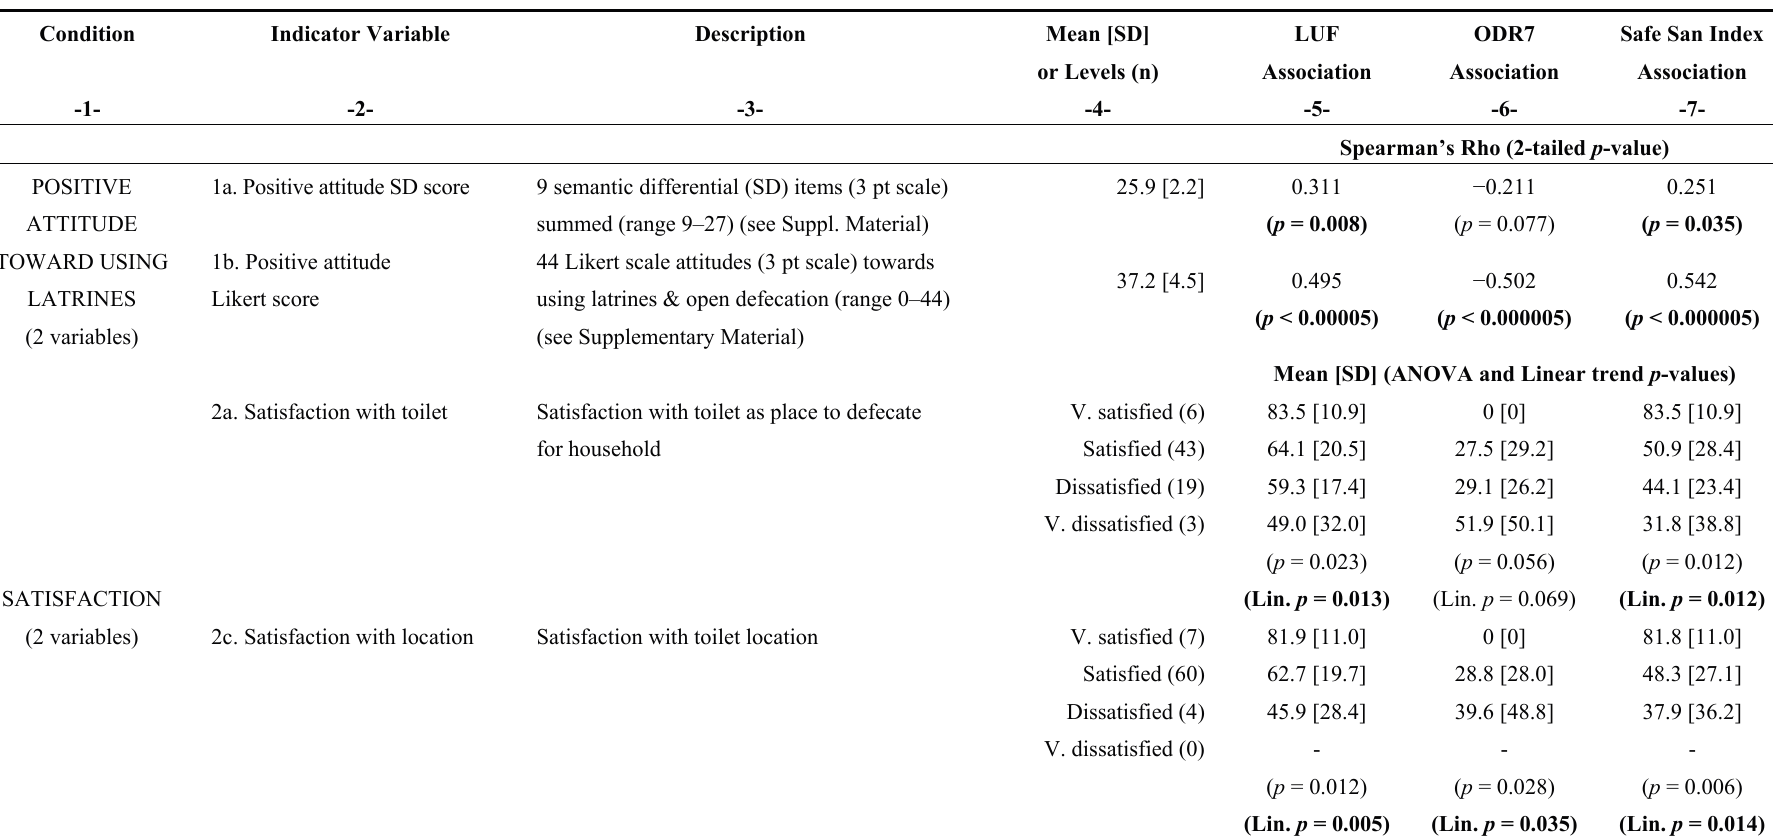
Table 5. External validity of the Safe San Index and its components: statistical tests of association in the expected direction with conditions for high latrine use and low open defecation behavior (71 households with functioning latrine at F1) ( p -values < 0.05 in bold).